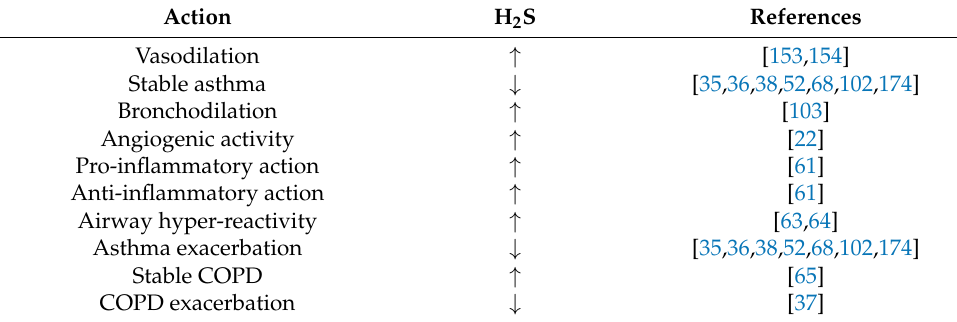
Table 1. Pathophysiological actions of H 2 S in the